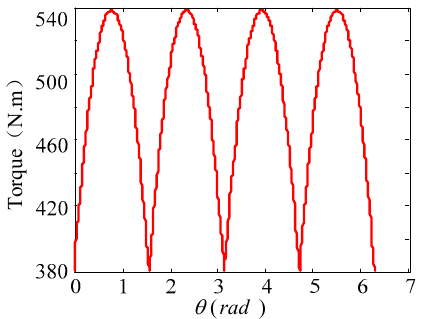
Figure 9. The curve of the wobble plate joint output torque.